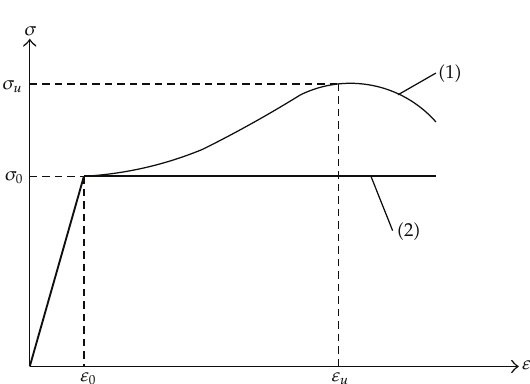
Figure 4: Real (cid:6) 1 (cid:7) and idealized (cid:6) 2 (cid:7) constitutive law of standard construction